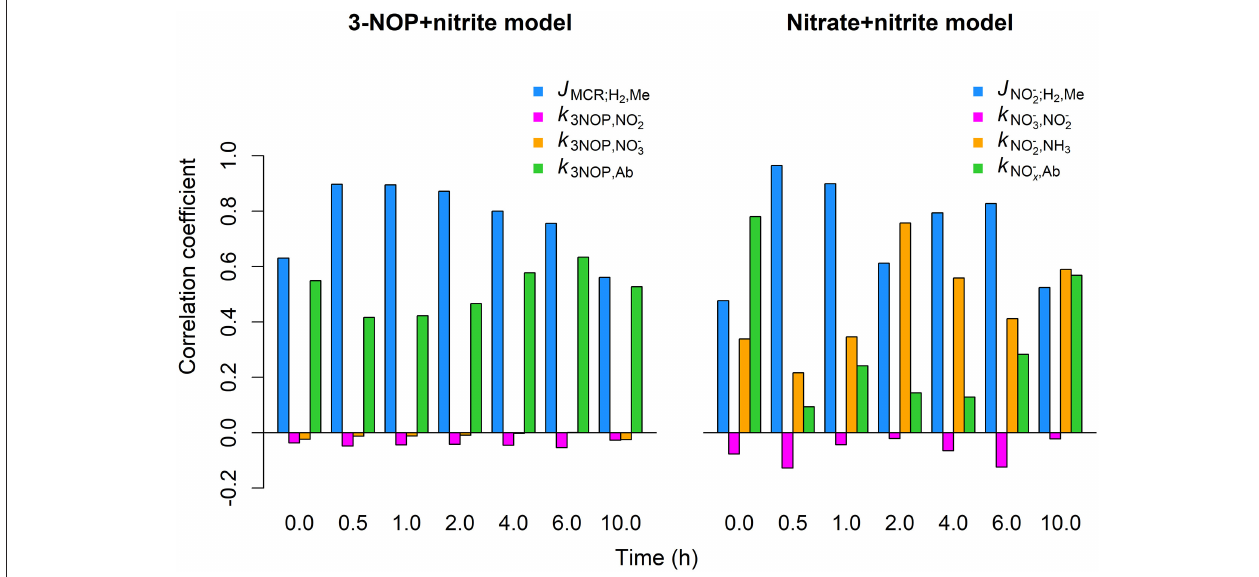
FIGURE 7 | Correlation between CH 4 emission rate and parameter values obtained from global sensitivity analysis for the 3-NOP+nitrite and nitrate+nitrite model when using inclusion rates of 1.0 mmol · kg − 1 for 3-NOP and 0.32 mol · kg − 1 for nitrate and the Van Lingen et al. (2017) feed input. Parameters values were drawn from the interval of 0.75 to 1.25 times their optimum value (see Table 3 ) using latin hypercube sampling and a sample size of 1,000. Correlation coefficents were calculated at 0, 0.5, 1, 2, 4, 6, and 10 h from the last meal of a 240 h